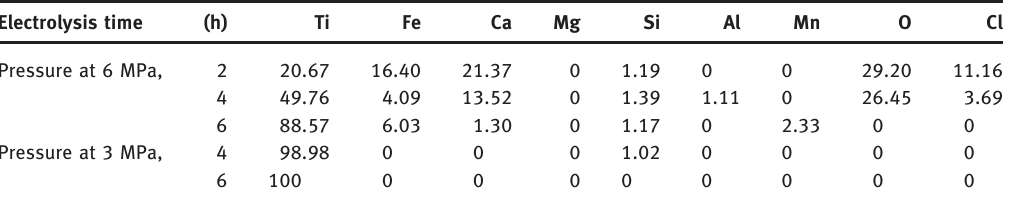
Table 3: EDX results of the electrolytic products for titanium-rich residue under different conditions (wt%). Electrolysis time Pressure at  MPa,